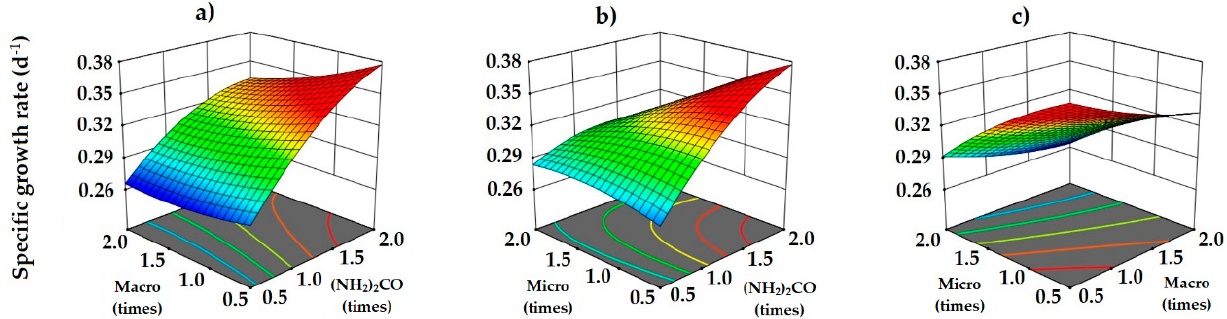
Figure 2. Response surface plots showing the interaction effects of ( a ) other macronutrients (Macro) and (NH 2 ) 2 CO; ( b ) micronutrients (Micro) and (NH 2 ) 2 CO, and ( c ) Macro and Micro of the photoautotrophic cultures.